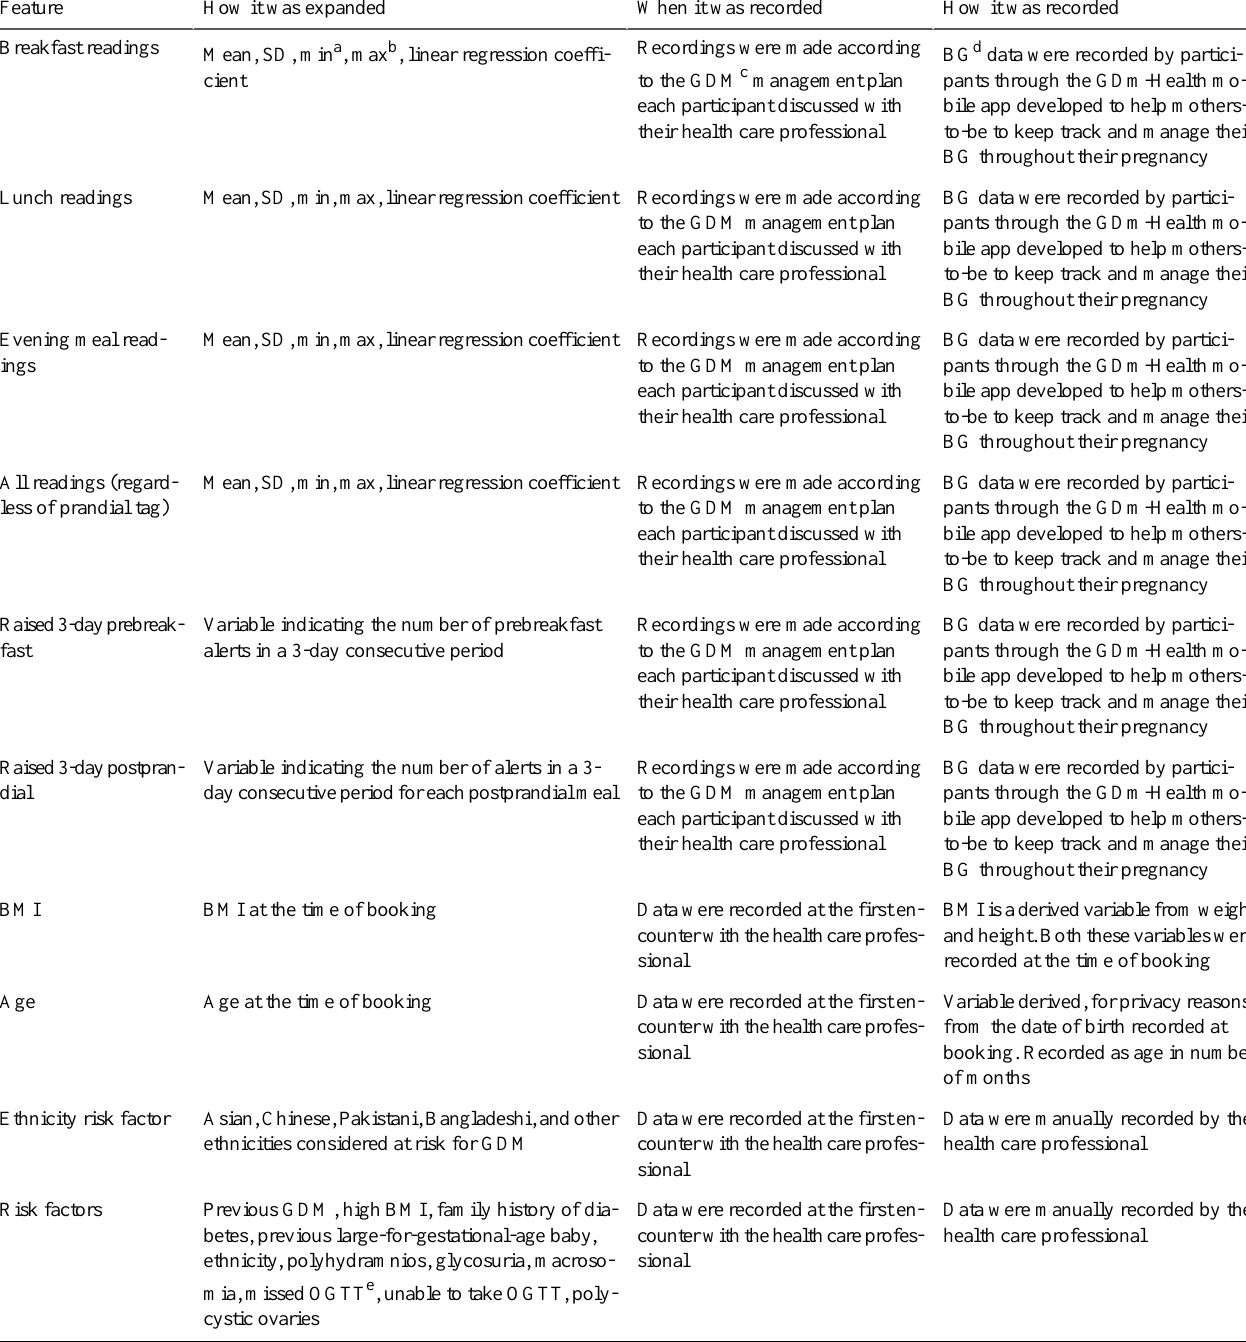
Table 1 lists the set of predictors used for our analysis, together with a detailed explanation of their nature, including the time and the way in which they were recorded. The majority of predictors describe the BG level at different times of the day Table 1. Description of predictors used in this